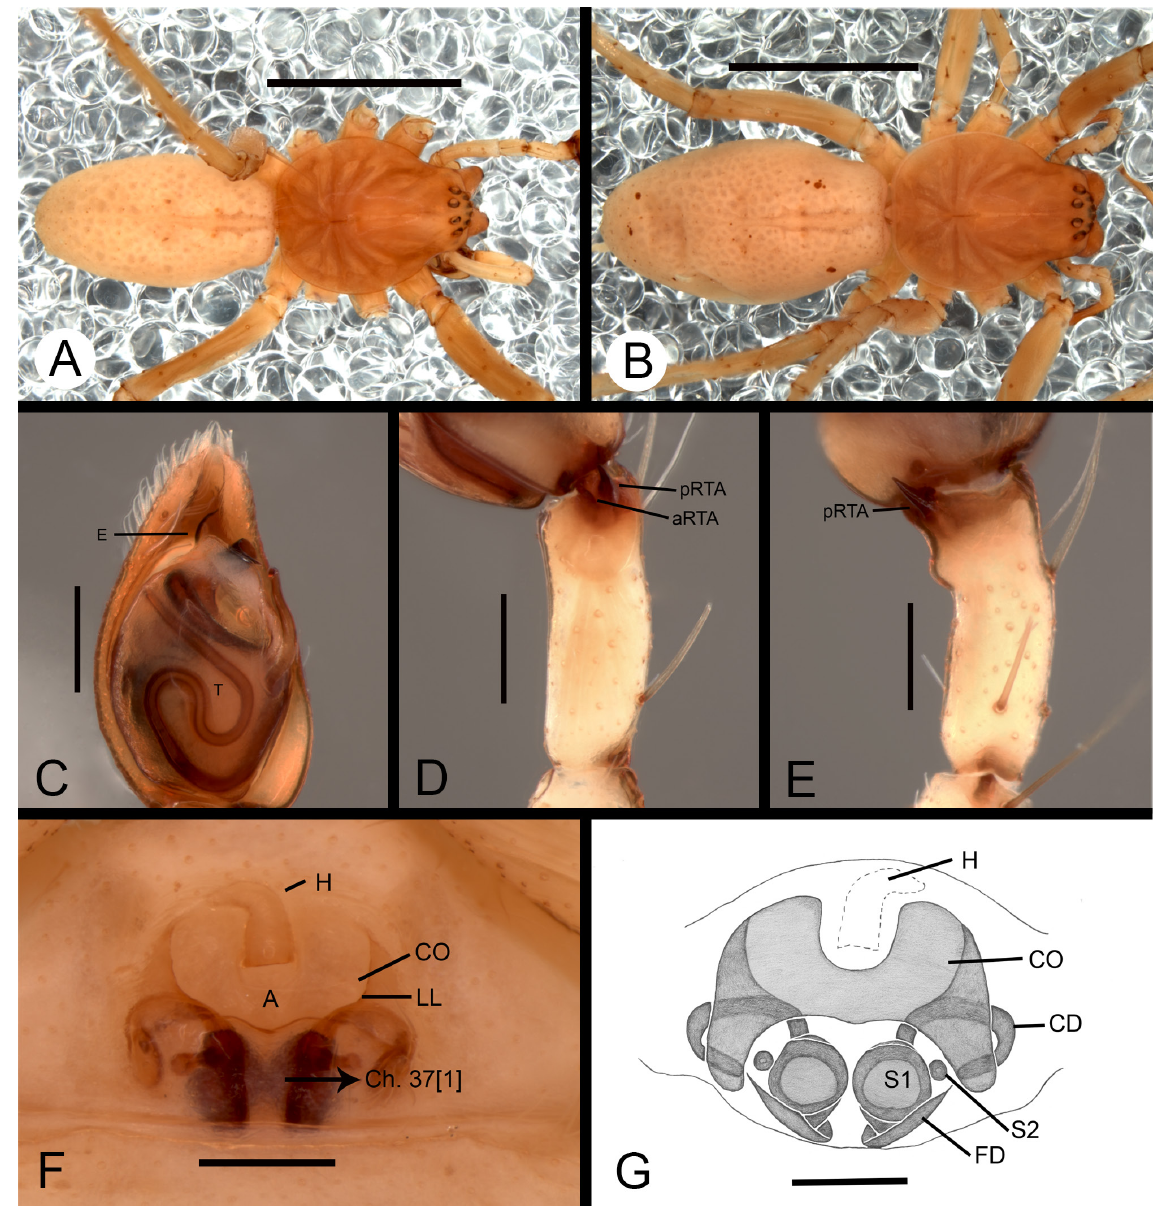
Fig. 27. Tafana arawak sp. nov. (A, C–E = holotype, ♂, MNHN 11320; B, F–G = paratype,♀, MNHN 11320). A . Habitus, dorsal view. B . Habitus, dorsal view. C . Left palp, ventral view. D . Left palp, retrolateral view. E . Left palp, dorsal view. F . Epigynum, ventral view (arrow indicating character). G . Vulva, dorsal view. Abbreviations: A = atrium; aRTA = anterior branch of the retrolateral tibial apophysis; CD = copulatory ducts; CO = copulatory opening; Ch = character; E = embolus; FD = fertilization ducts; H = hood; LL = lateral lobes; pRTA = posterior branch of the retrolateral tibial apophysis; S1 = primary spermathecae; S2 = secondary spermathecae; T = tegulum. Scale bars: A–B = 3.5 mm; C–G = 0.25